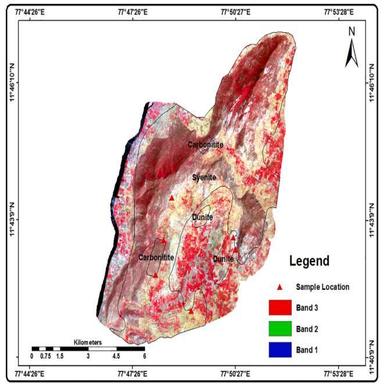
False color composite image of Pakkanadu Carbonatite Complexes generate using ASTER band 3, 2, 1 in RGB and the carbonatite enhanced in brown color, syenite in red color and dunite in cyan color.